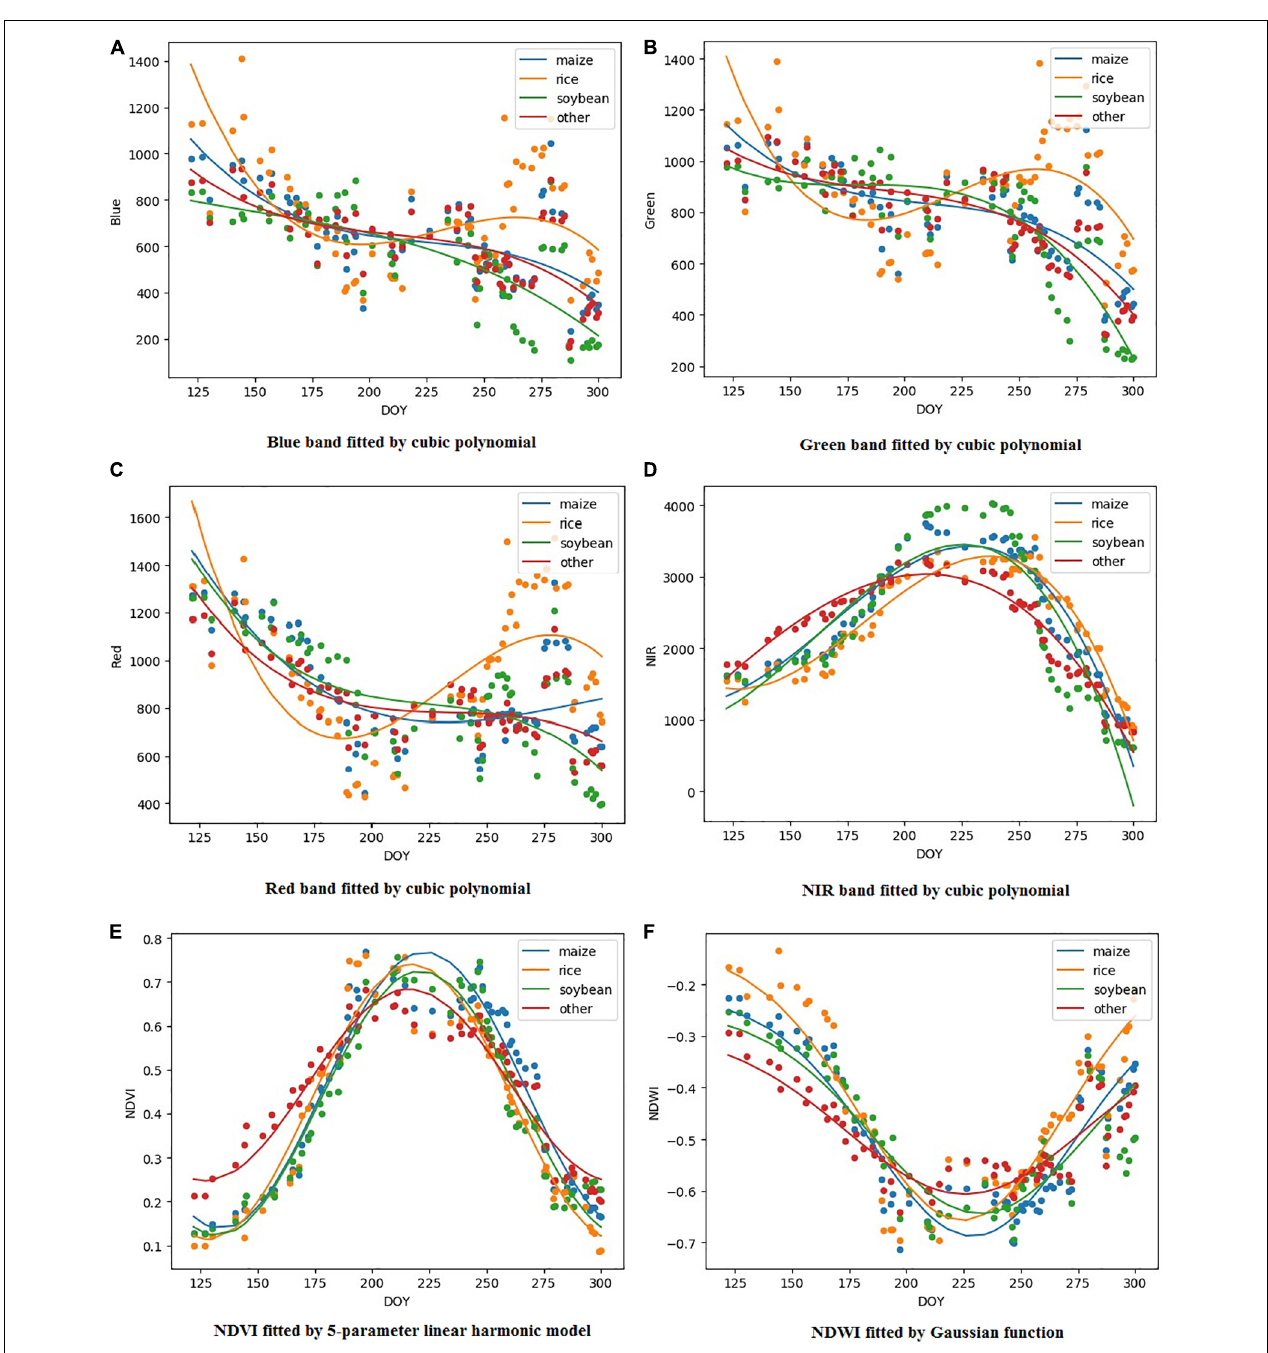
FIGURE 6 | Curve fitting result, where (A–D) are the cubic polynomial fitting results of the blue, green, red, and NIR bands, (E) is the NDVI fitted by the 5-parameter linear harmonic model, and (F) is the NDWI fitted by the Gaussian function.